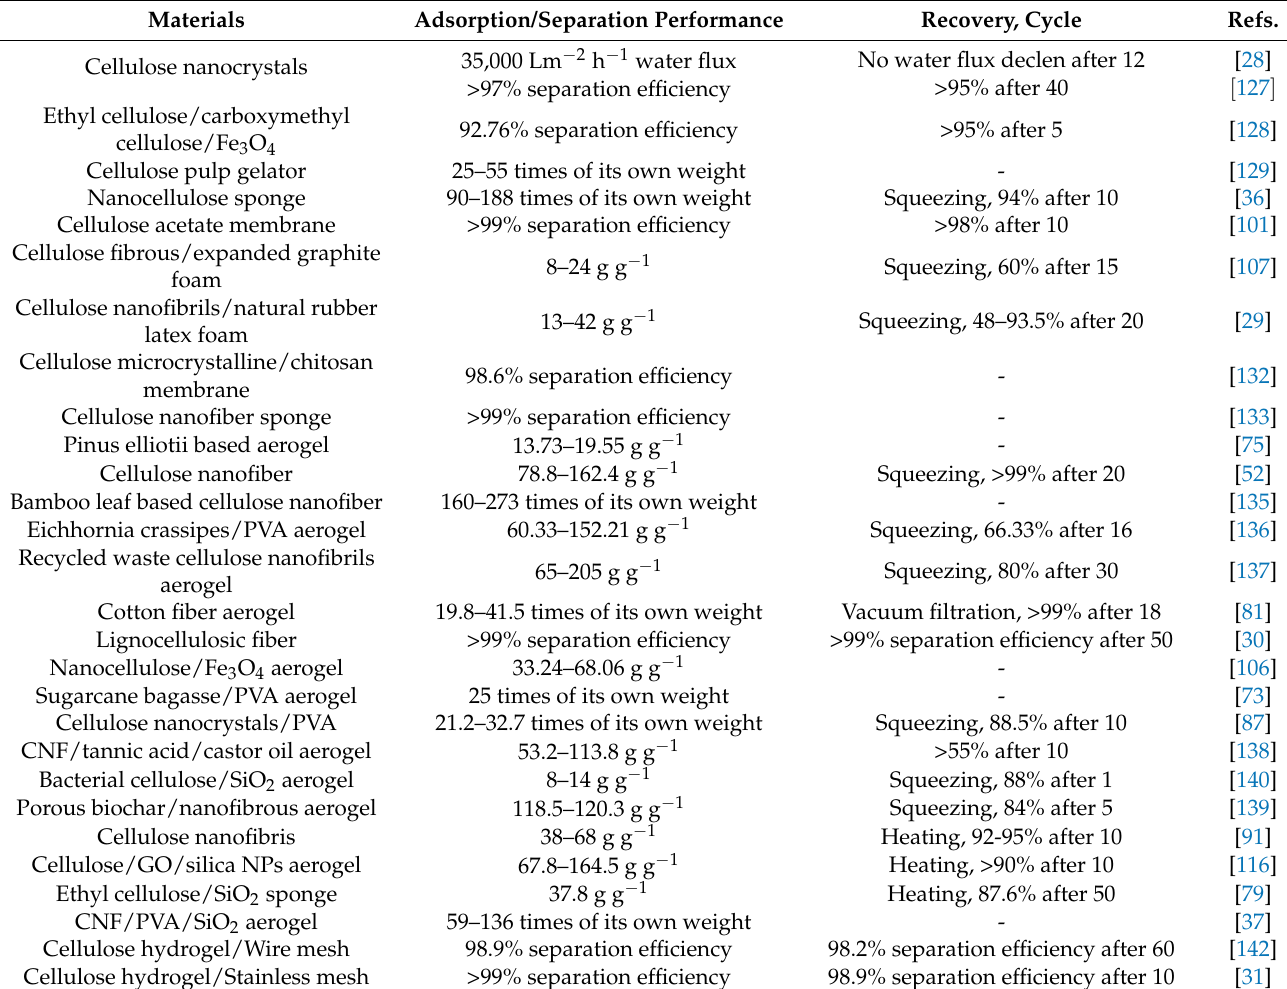
Table 4. Cellulose based sorbents for spill oil